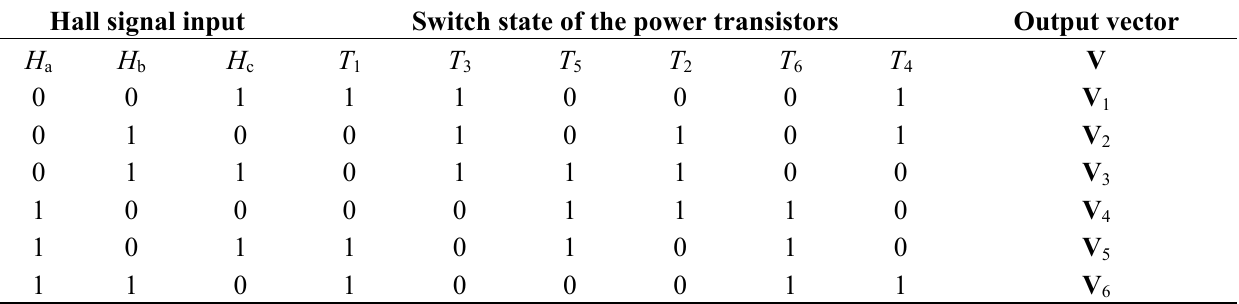
Table 2. Switch table of the power converter in which three power transistors conduct at the same time in each